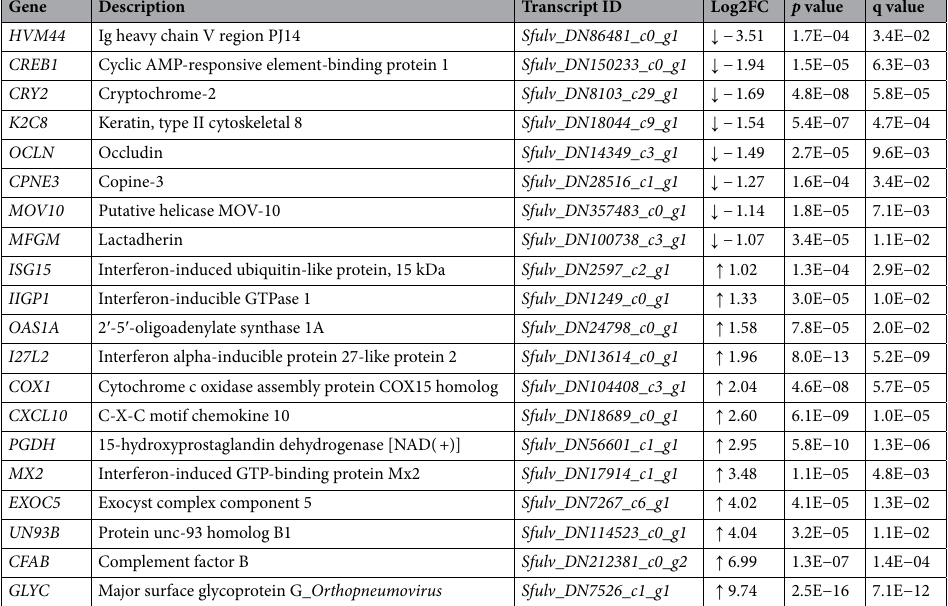
Table 2. Twenty notable differentially expressed genes in S. fulviventer lung following RSV infection. Negative Log2FC = downregulated, positive Log2FC = upregulated. Gene names/descriptions determined by BlastX against UniRef/SwissProt. Transcript IDs correspond to contig names (Sfulv_xxx) in assembly FASTA file. Log2FC = log2FoldChange, q =